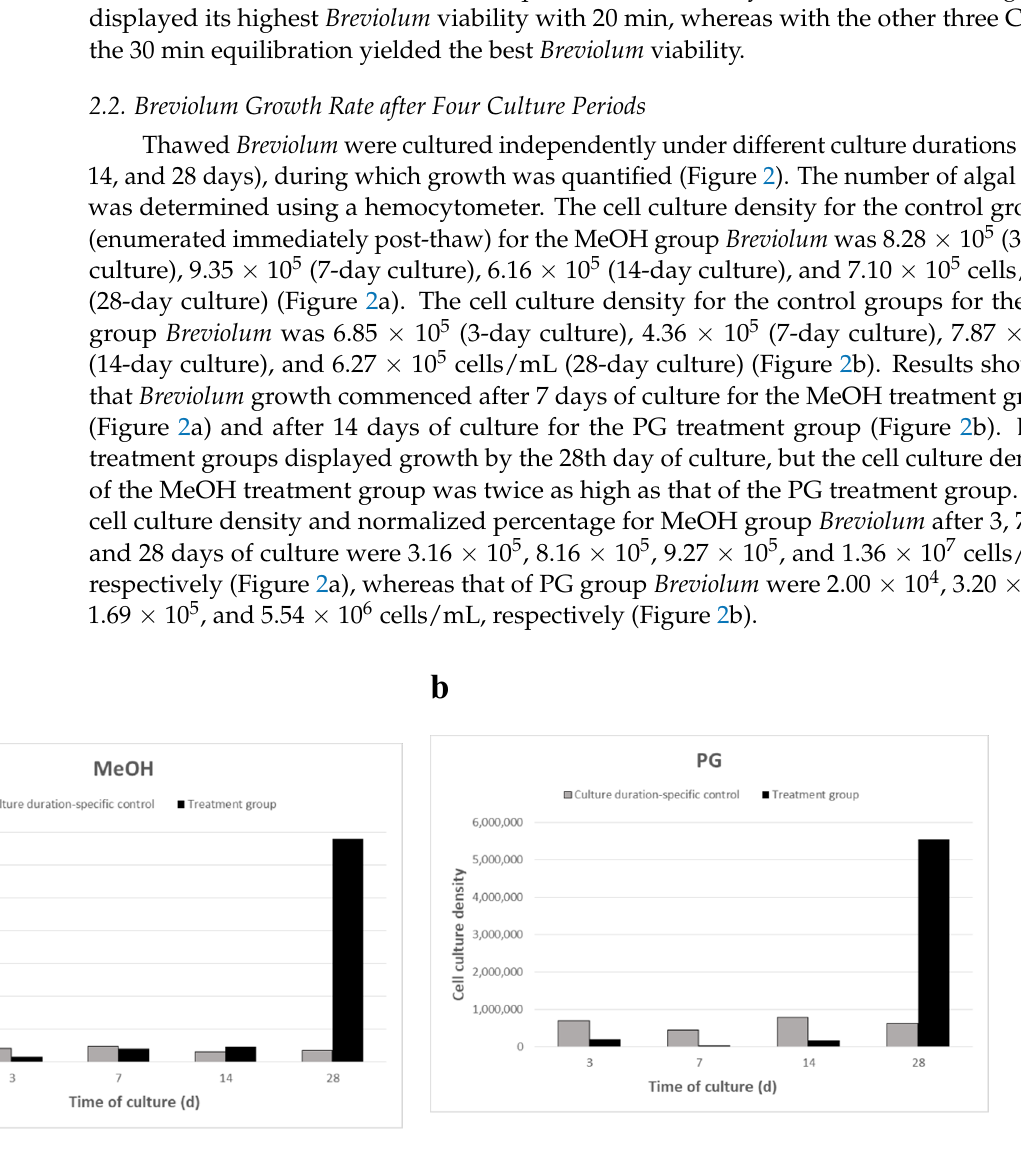
Figure 2. Cell culture density for the MeOH ( a ) and PG ( b ) treatment groups of thawed Breviolum after 3, 7, 14, and 28 days of culture; each culture duration trial was conducted independently. Control densities for the MeOH treatment: 3.16 × 10 5 (3-day culture), 8.16 × 10 5 (7-day culture), 9.27 × 10 5 (14-day culture), and 1.36 × 10 7 cells/mL (28-day culture); PG treatment: 2.00 × 10 4 (3-day culture), 3.20 × 10 4 (7-day culture), 1.67 × 10 5 (14-day culture), and 5.54 × 10 6 cells/mL (28-day culture).The horizontal axis shows the number of days of culture, at which 0 days represents the cell population immedi- ately after thawing.